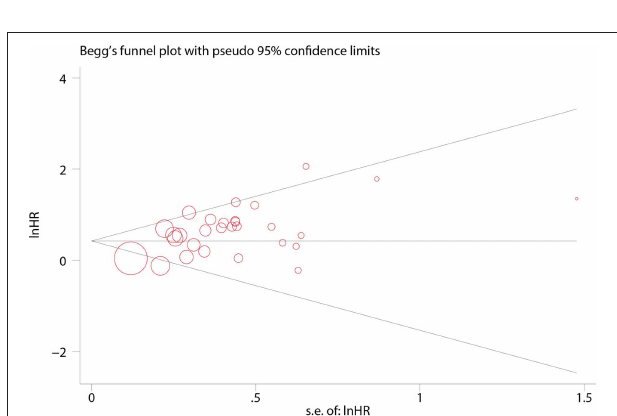
FIGURE 4 | Funnel plot for the publication bias